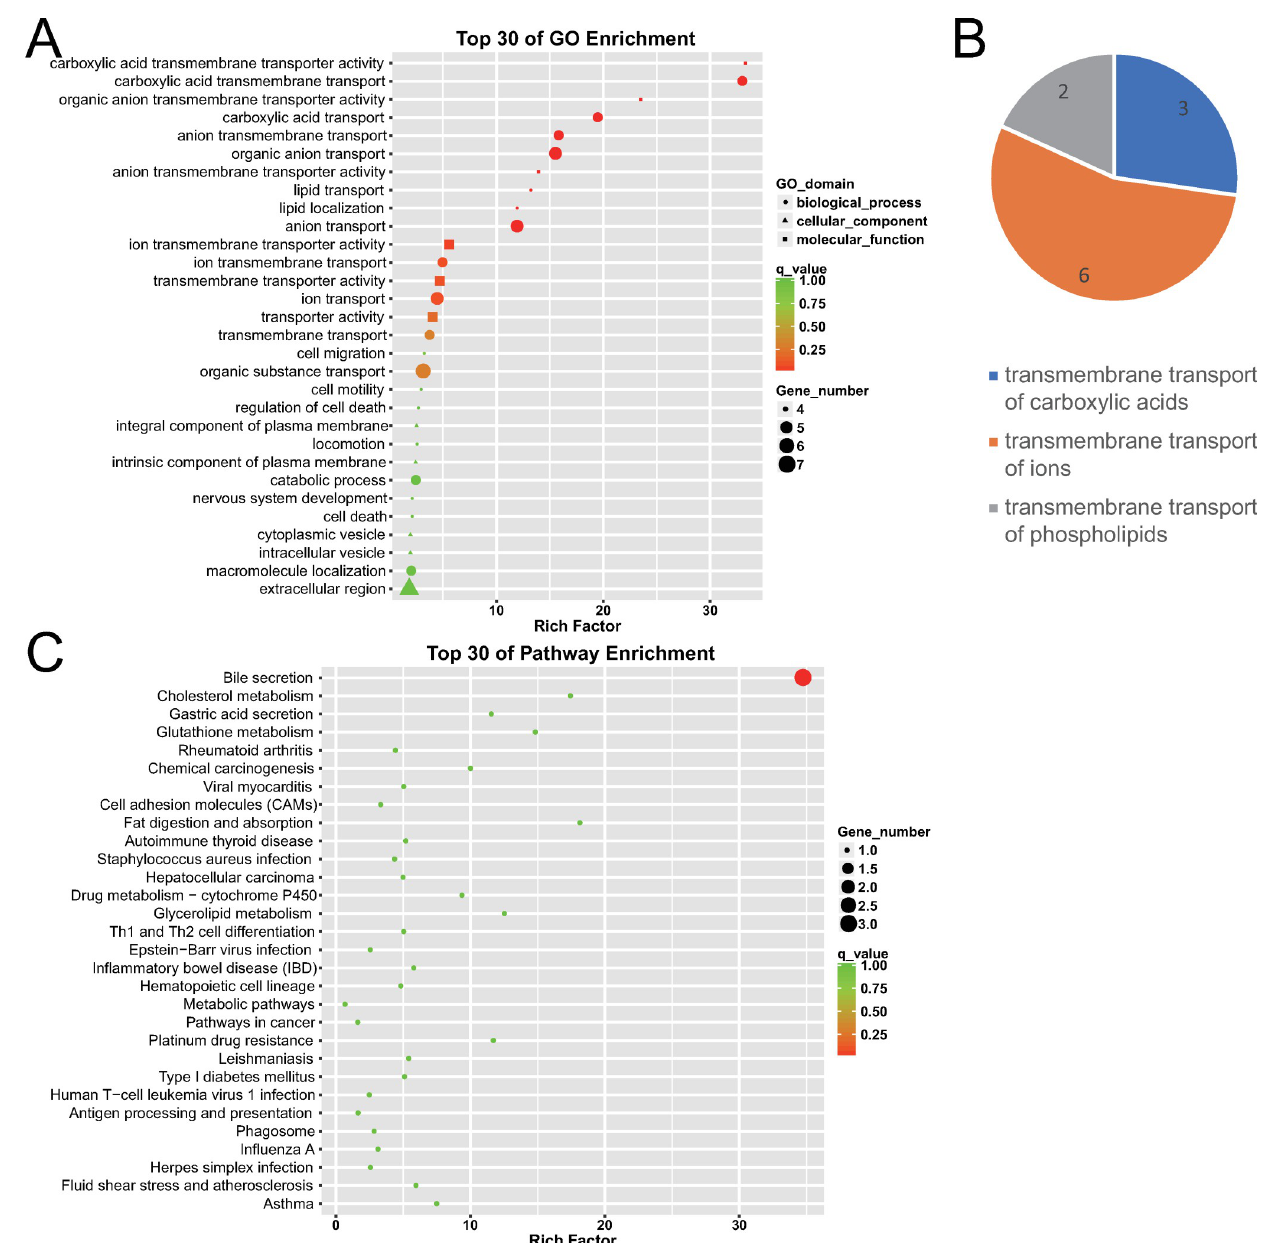
Fig 7. GO and KEGG enrichment analysis of differentially expressed mRNAs between early GBC and advanced GBC. (A) The top 30 GO terms with a high degree of enrichment. The shapes of icons represent different GO categories, the size represents the number of differentially expressed genes contained by this GO term, the color depth represents the size of the q-valueand the X axis indicates the value of rich factor. (B) The 11 GO terms with q-value � 0.05 were further classified. Numbers on the graphrepresent the number of GO terms corresponding to the category. (C) The top 30 KEGG terms with a high degree of enrichment. The size of icons represents the number of differentially expressed genes contained by this KEGG term, the color depth represents the size of q-valueand the X axis indicates the value of the rich factor.